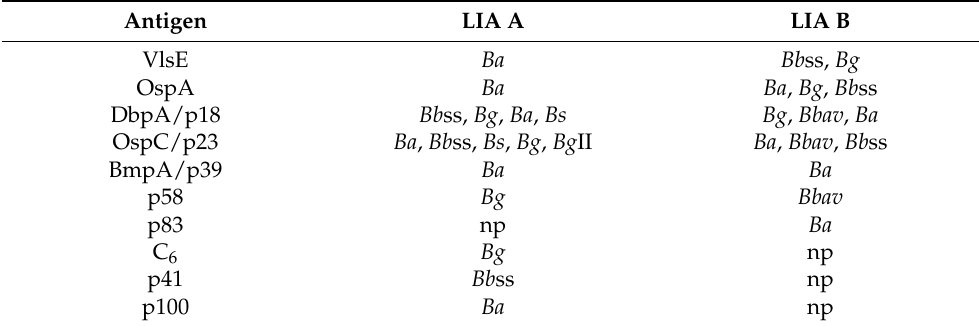
Table 2. Recombinant antigens sprayed on the nitrocellulose strips of both LIAs.